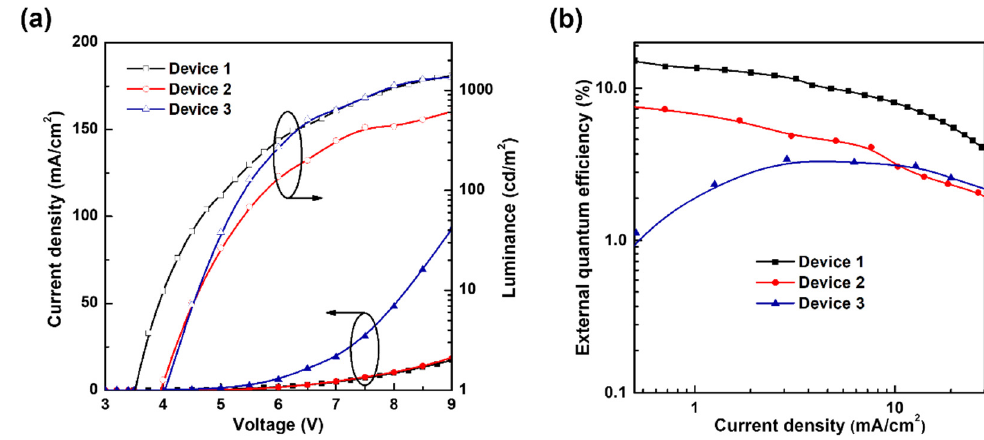
Figure 2. ( a ) J-V-L characteristics and ( b ) J-EQE characteristics of devices 1, 2, and 3. Table 2. EL characteristics of devices 1, 2, and 3.